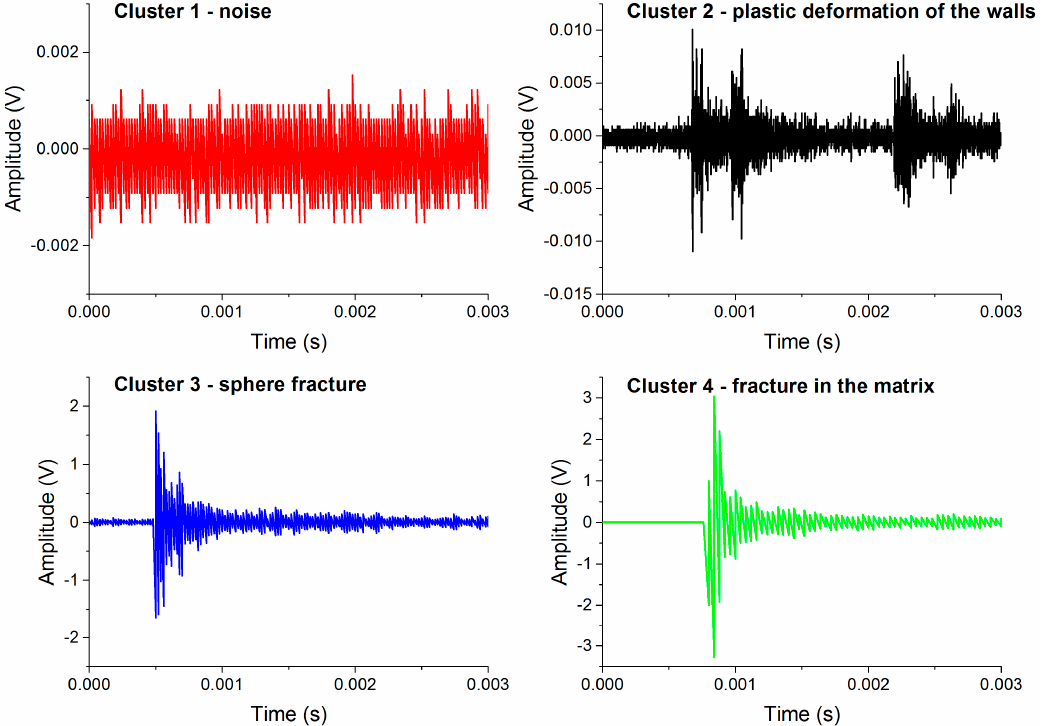
Figure 4. Characteristic AE waveforms corresponding to different clusters in AlSi12 foam: Cluster 1: noise; Cluster 2: plastic deformation of the walls; Cluster 3: sphere fracture; and Cluster 4: fracture in the brittle phase of the matrix.